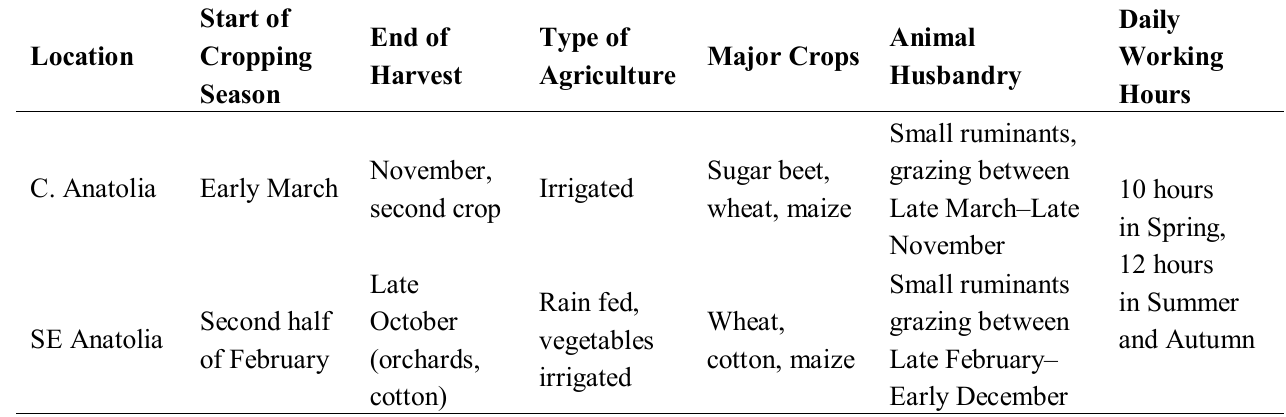
Table 1. Agricultural calendar and crops in project side.